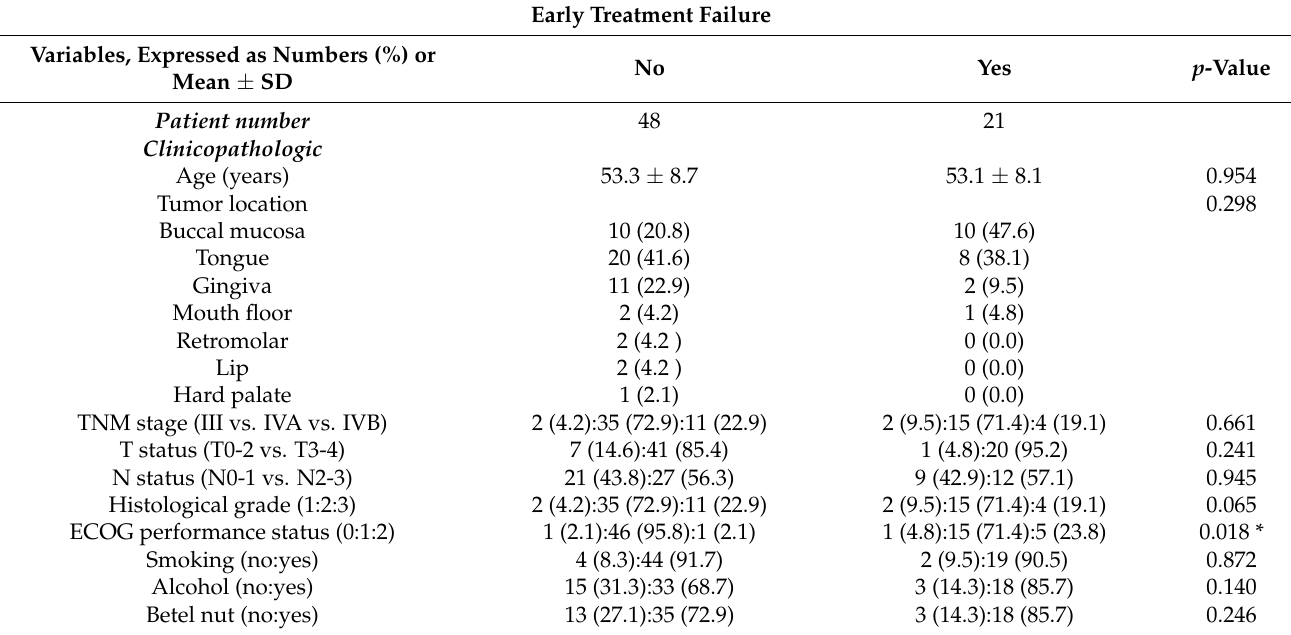
Table 3. The characteristic variations between patients with and without early treatment failure in 69 oral cavity cancer patients following CCRT